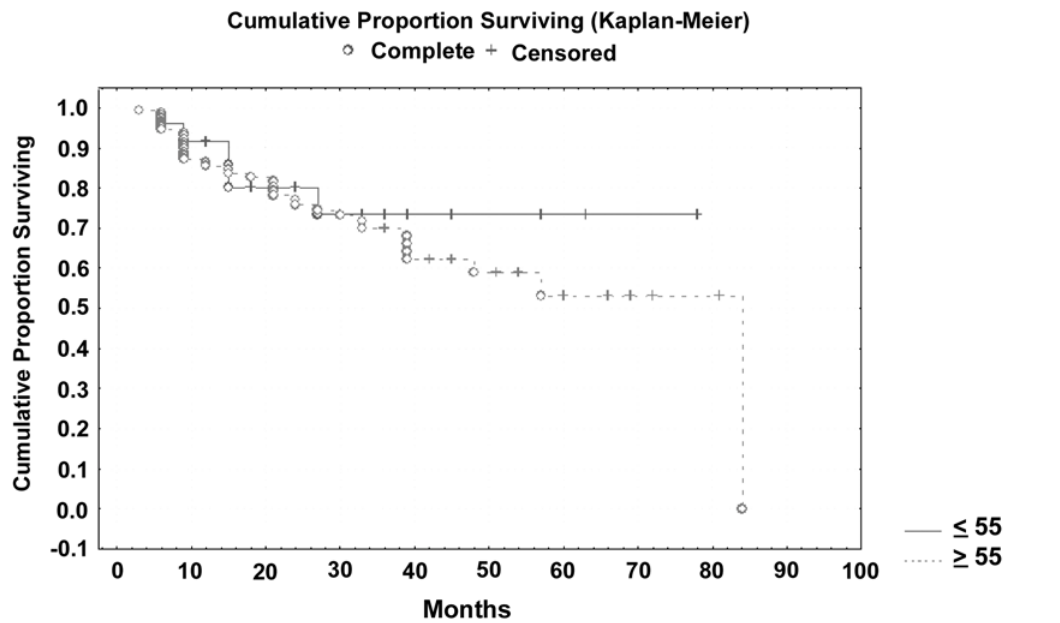
Figure 1 – Time to PSA progression postoperatively according to age ( ≤ 55 year-old or > 55 year-old). Kaplan-Meier product-limit analysis (log-rank: P =